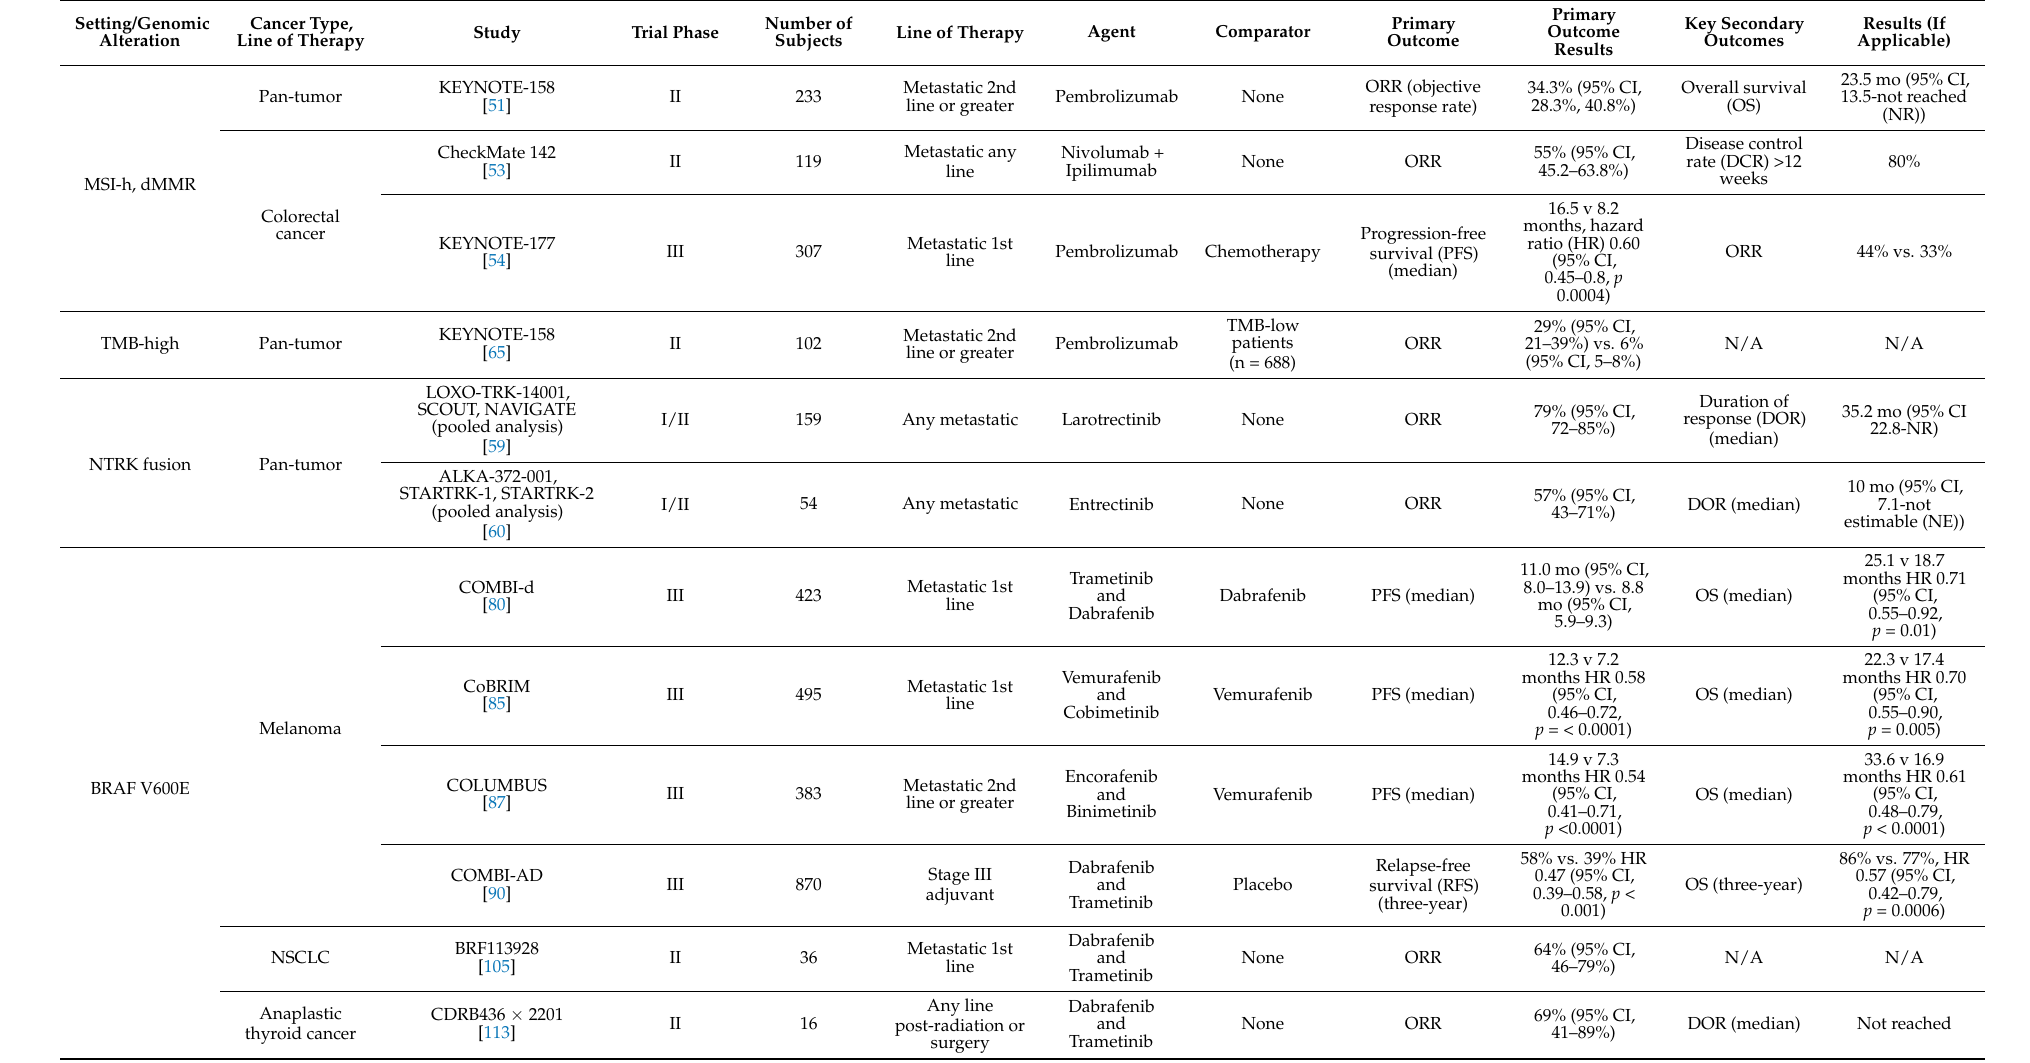
Table 2. Key pivotal trials leading to FDA approval in alterations with multiple tumor indications (MSI-h, TMB-h, NTRK fusion, BRAF , HER2, RET, BRCA